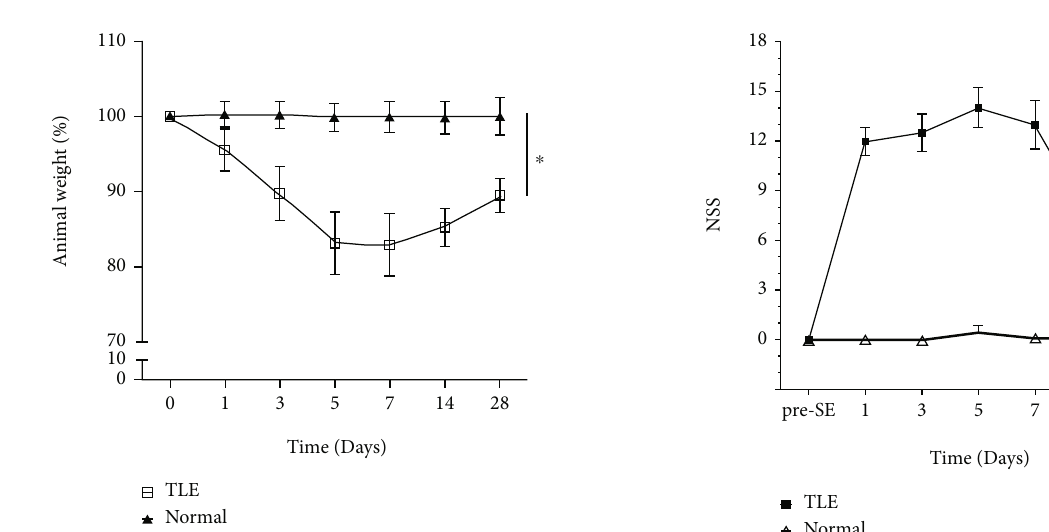
Figure 2: The sensorimotor de fi cits of TLE rats. The sensorimotor de fi cits of TLE rats were assessed on D1, D3, D5, D7, D14, and D28 after SE and pre-SE, calculated as the mNSS. The data were represented as mean ± SD . ∗ P < 0 : 05 , vs. the normal